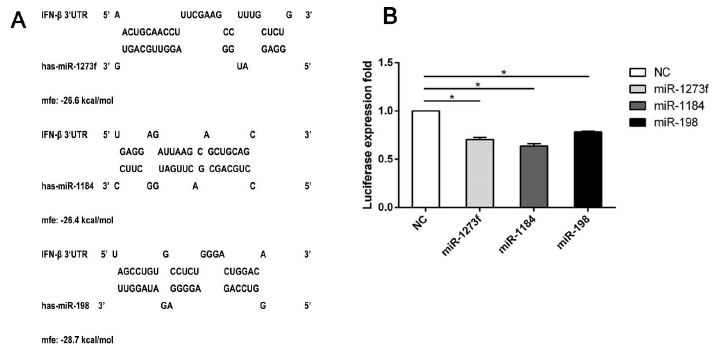
Figure 5. miRNAs (miR-1273f, miR-1184, and miR-198) may interact with the predicted target sites in the 3 (cid:48) UTR of IFN- β mRNA. ( A ) Predicted target sites for miR-1273f, miR-1184, and miR-198 in IFN- β 3 (cid:48) UTR mRNA were shown. Nucleotide positions in the 3 (cid:48) UTR, which were complementary to the miR-1273f, miR-1184, and miR-198 seed region, were indicated. ( B ) E ff ect of miR-1273f, miR-1184, and miR-198 mimics on the luciferase expression of reporter constructs containing the putative miRNA binding sites from the IFN- β 3 (cid:48) UTR was shown. The values were expressed as the mean of the results from three independent experiments, with the error bar showing standard deviations. Statistical significance is indicated: * p <